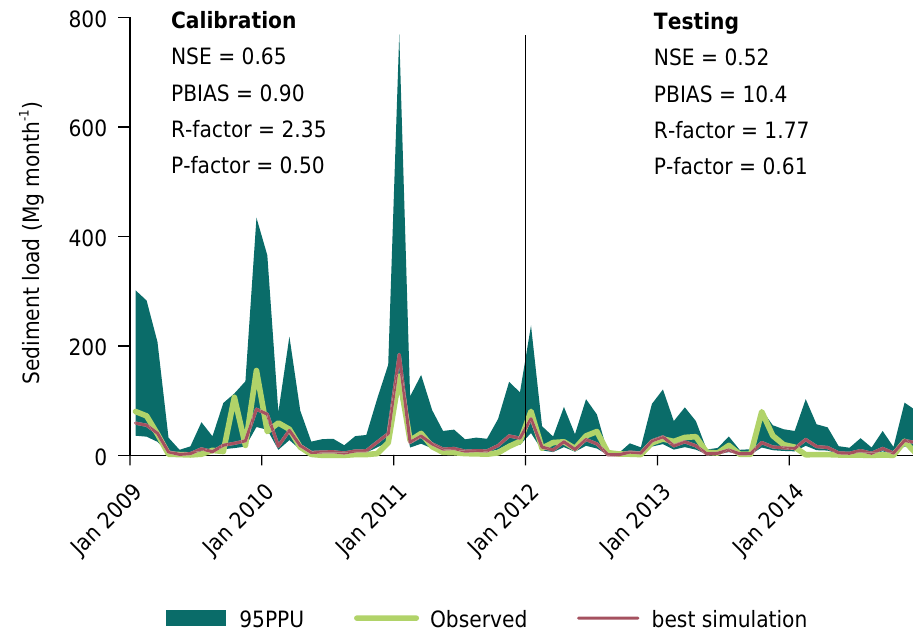
Figure 4. Observed and simulated sediment load for calibration and testing periods with the evaluation indexes. Calibration period: January of 2009 to December 2011; testing period: January 2012 to December 2014.